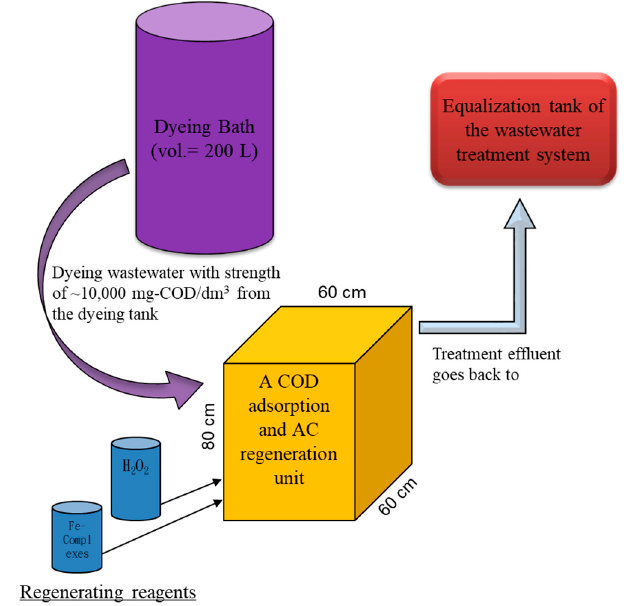
Figure 10. A proposed layout of the two-step treatment unit in treating a high-COD dyeing effluent directly from a 200 L dyeing bath. The designed unit can handle the high-COD wastewater drained from the 200 L dyeing bath and starts its adsorption–oxidation cycle to remove the COD in the wastewater.